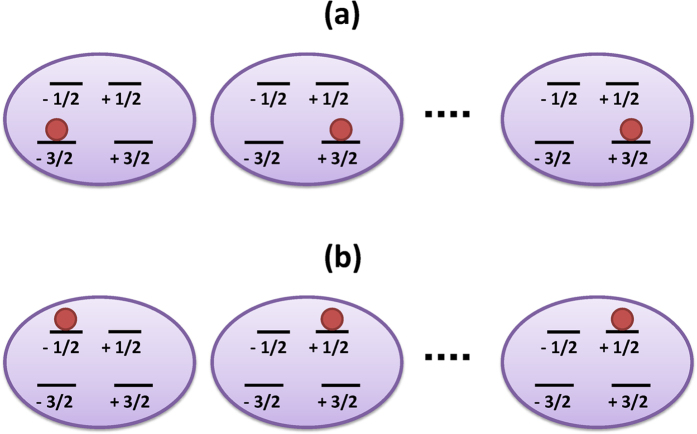
Low and high energy subspaces.Array of S = 3/2 spins with large negative zero-field splitting D initialized in: (a) the low-energy subspace in the state of ; (b) high-energy subspaces in the state of . The transition between the low and high energy subspaces can be achieved with a global resonant pulse.